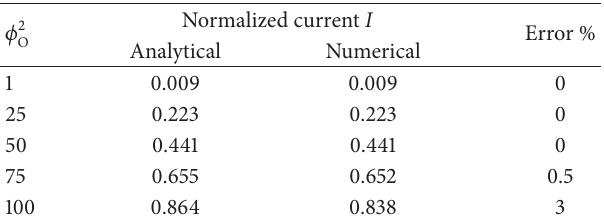
Table 3: Comparison of normalized current 𝐼 (18) with the numer- = 0.1 , 𝐵 = 0.01 , and 𝜇 = 0.05 and for various ical results when 𝐵 O S S values of 𝜙 2 O